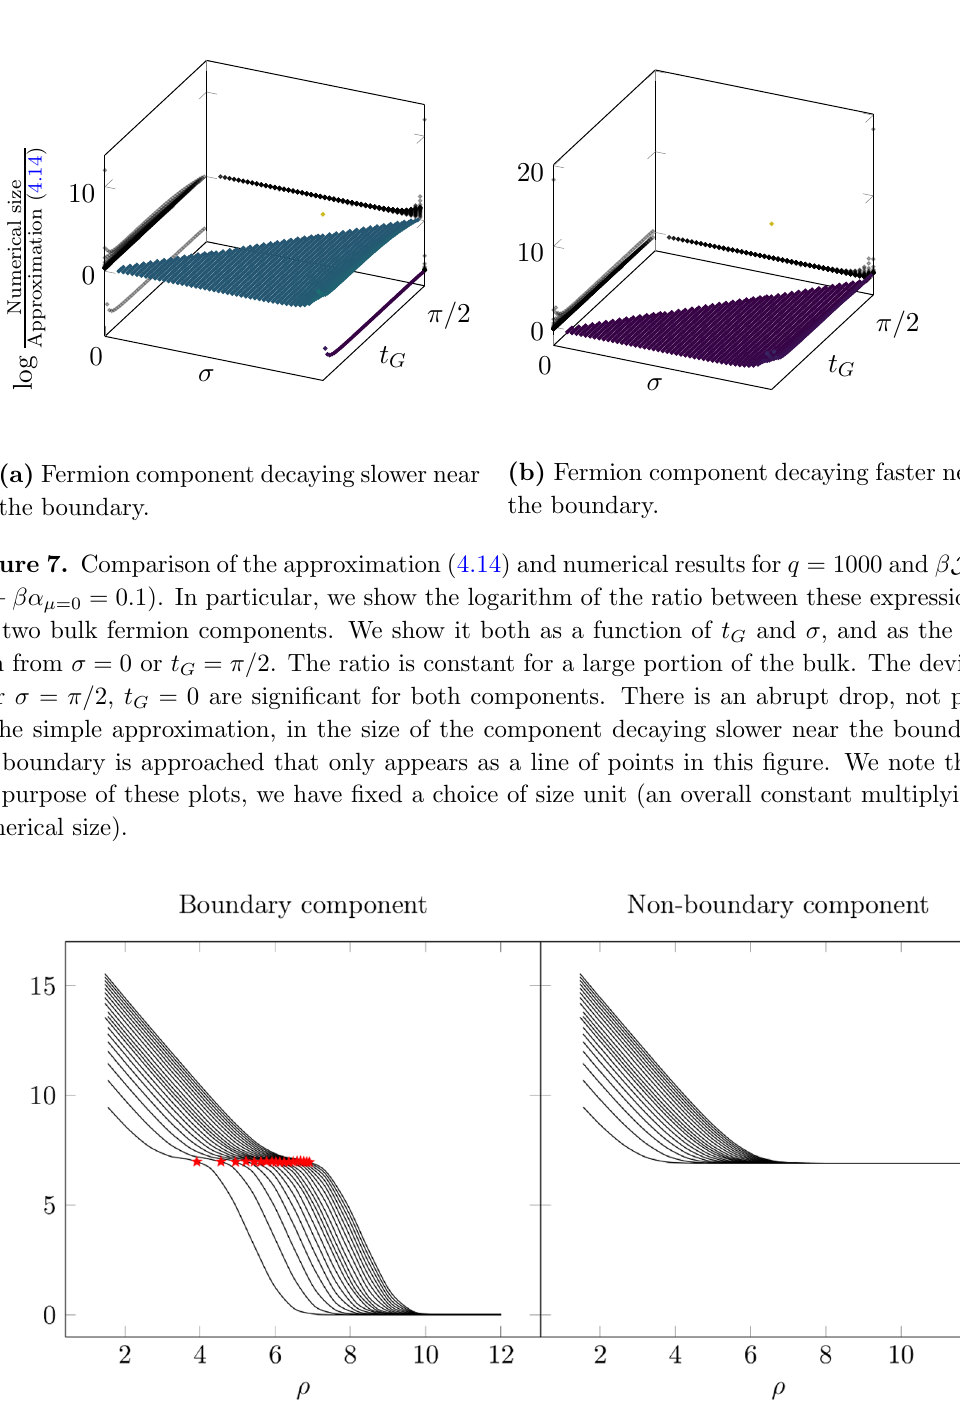
and q = 1000. Lines corresponding to higher (cid:12) J